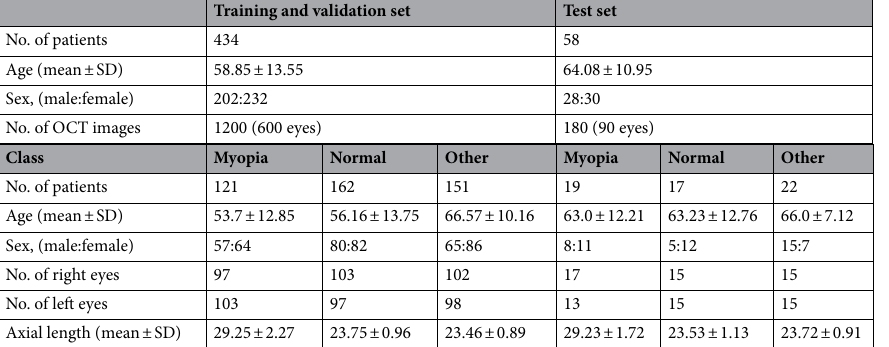
Training and validation set Test